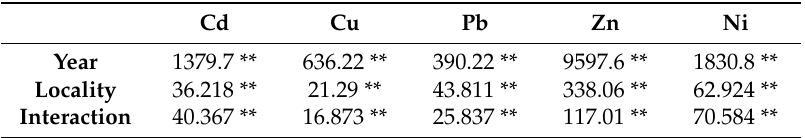
Table 5. PERMANOVA comparison of metal concentrations in sediments, denoted are F-criteria and their significance (** p <